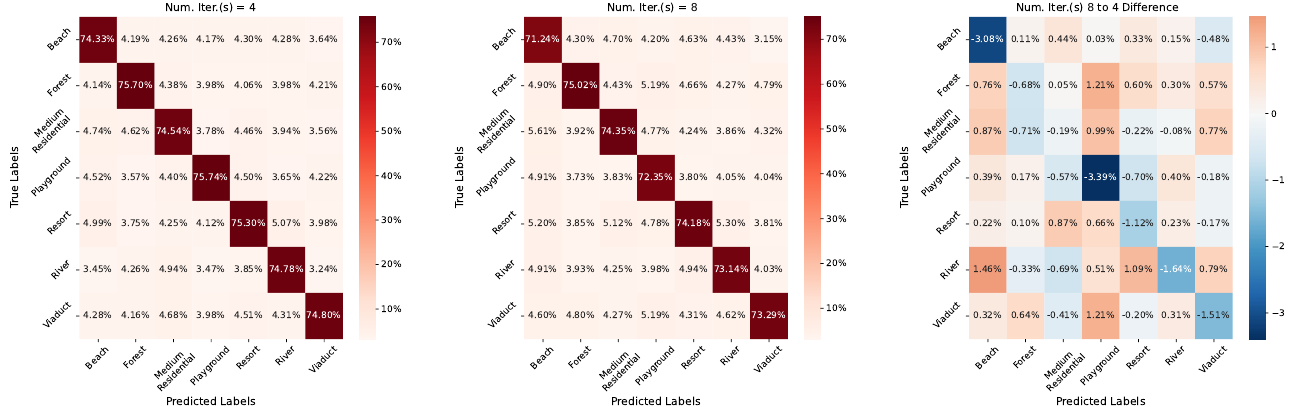
Figure 14. Confusion matrices and their difference on dataset AID with continual meta-learning iteration lengths 4 and 8.